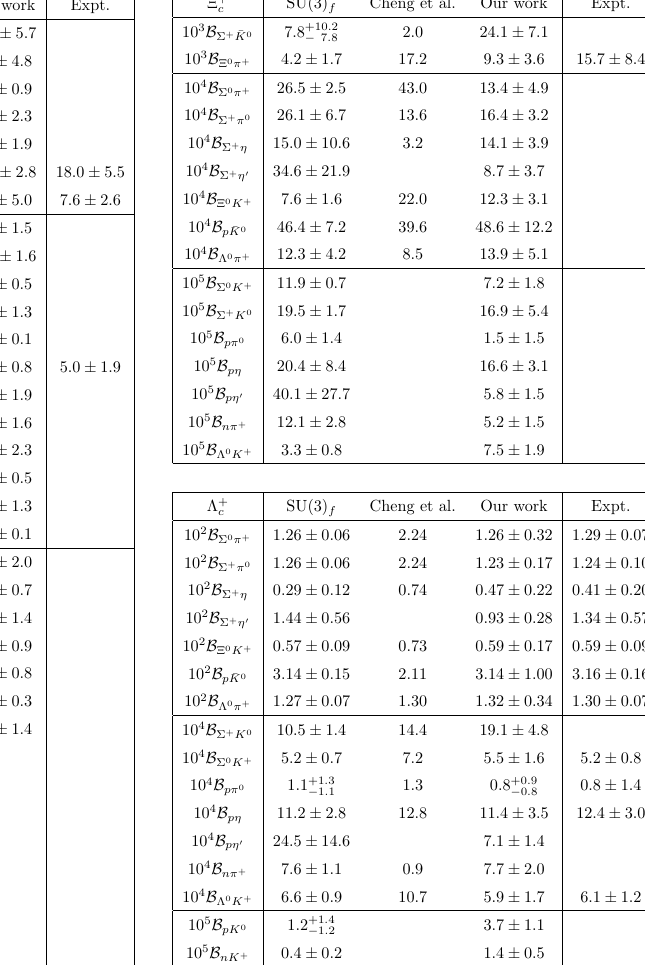
Table 3 . The numerical results of the B c with the results from the SU(3) f symmetry [31, 35] and the calculation with the pole model, current algebra and MIT bag model [32, 35]. The data of R 1 ; 2 ((cid:4) 0 ), c